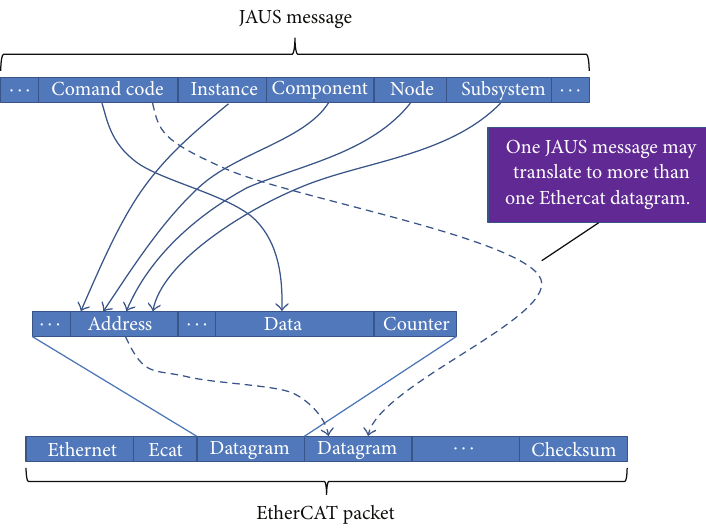
Figure 14: Address and data translation from JAUS to native EtherCAT.